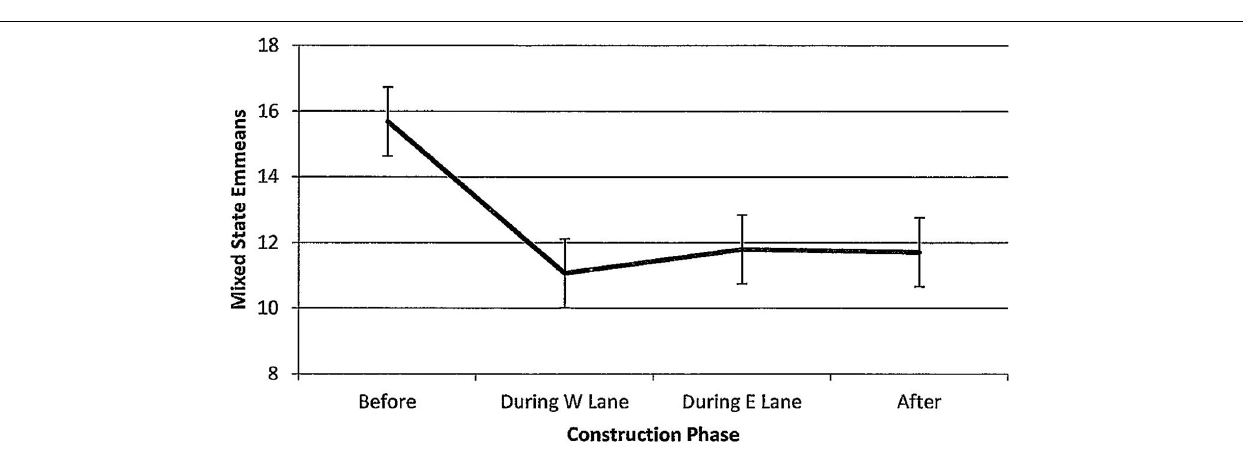
FIGURE 12 | Estimated marginal means of numbers of dolphins engaged in mixed states in the construction zone before, during, and after